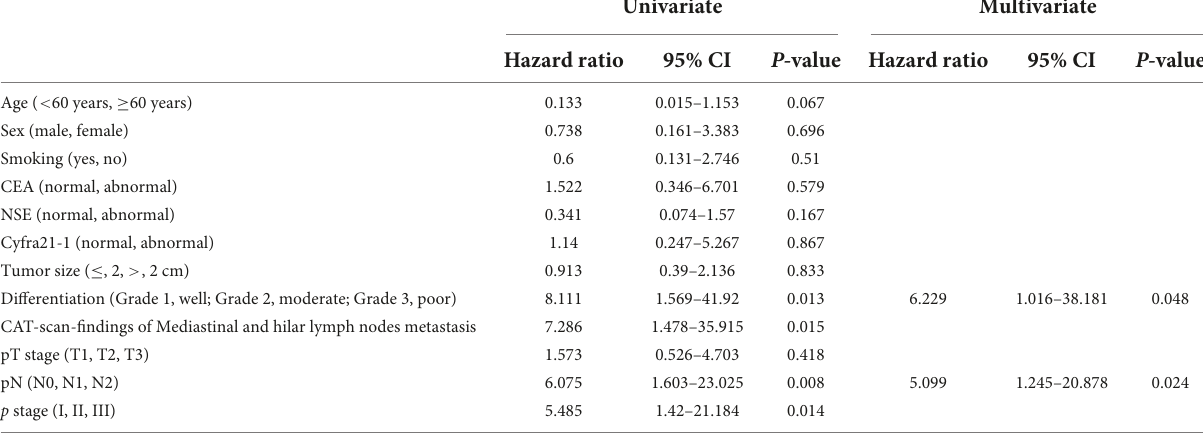
TABLE 4 Univariate and multivariate logistic analyses the impacts of the potential predictors of lymph node